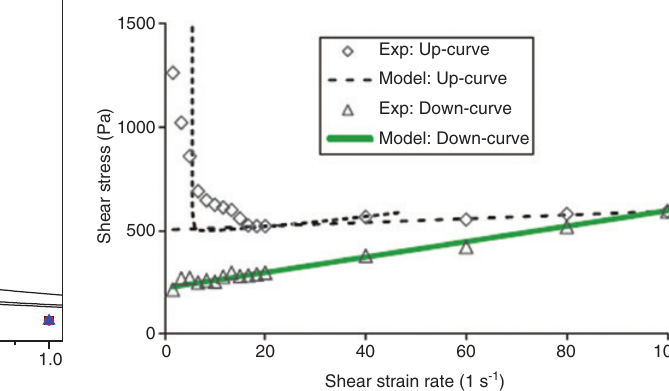
Figure 3: Shear stress vs. shear strain rate fitting with experimental